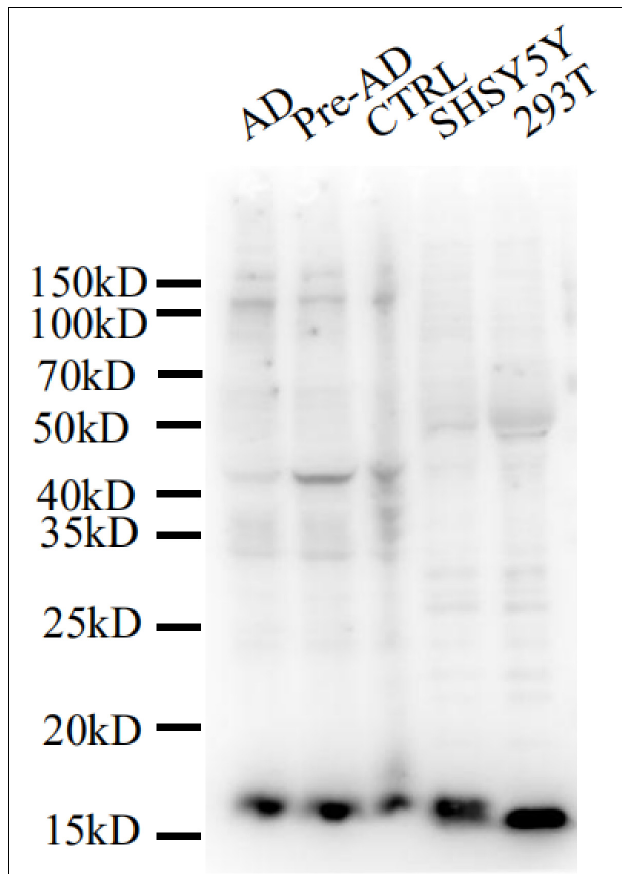
FIGURE 2 | Mesencephalic astrocyte-derived neurotrophic factor levels detected by western blotting with a polyclonal antibody. Cell lysis solutions and human brain temporal cortex protein extracts were probed with a polyclonal anti-MANF antibody to evaluate specificity. The immunoblot shows a clear single band of ∼ 18 kDa in all protein extracts and cell lysis solutions.